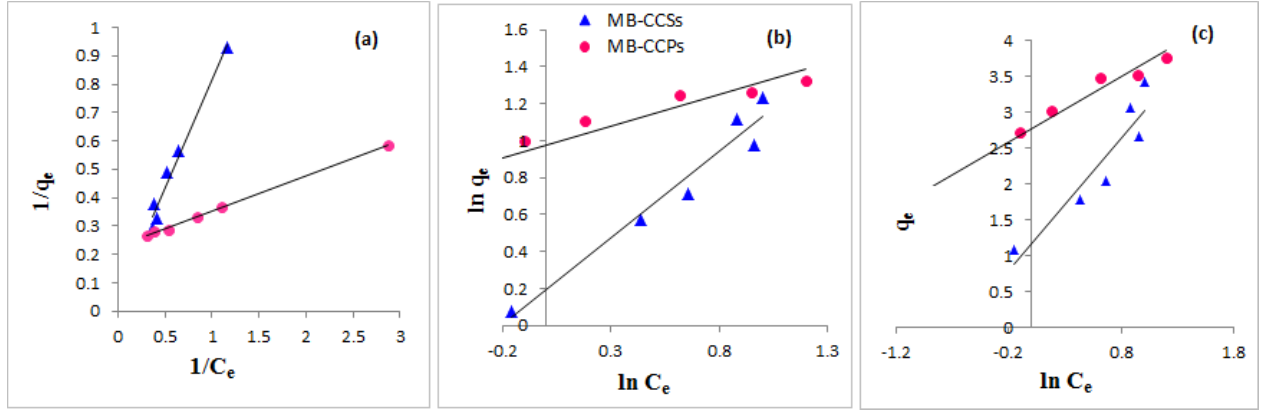
Figure 9. Adsorption Isotherm models: ( a ) Langmuir, ( b ) Freundlich, ( c ) Temkin.